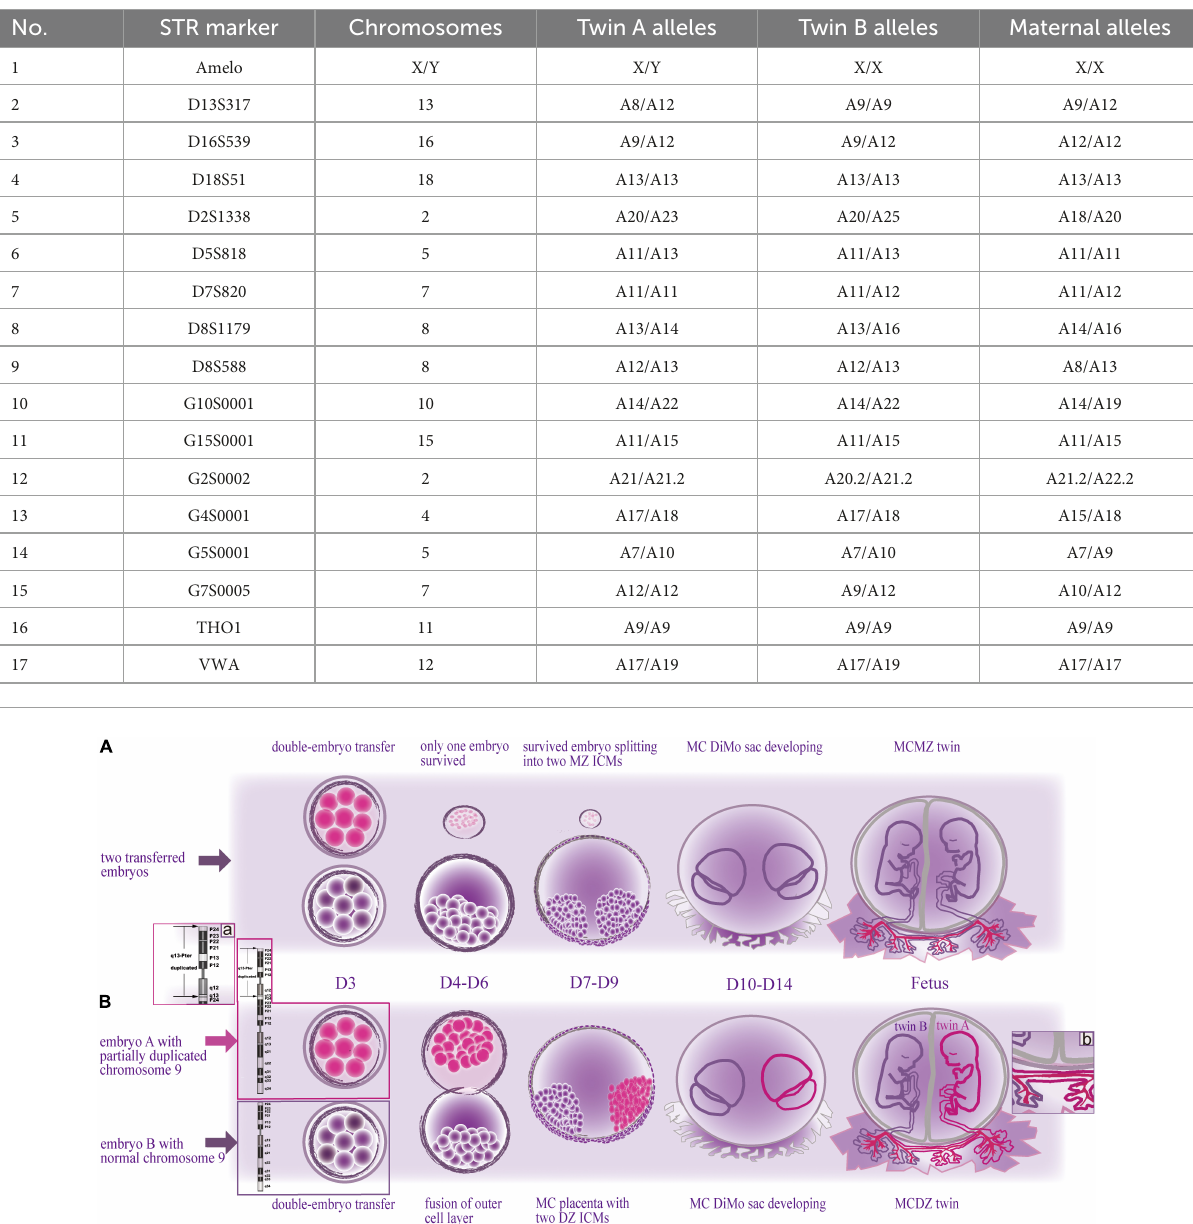
TABLE 2 DNA zygosity analysis in samples from each fetus and the maternal peripheral-blood lymphocytes. No.